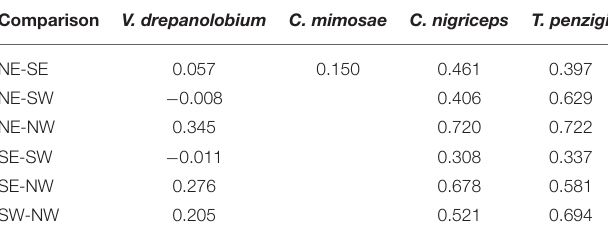
TABLE 5 | Pairwise FST between populations for each